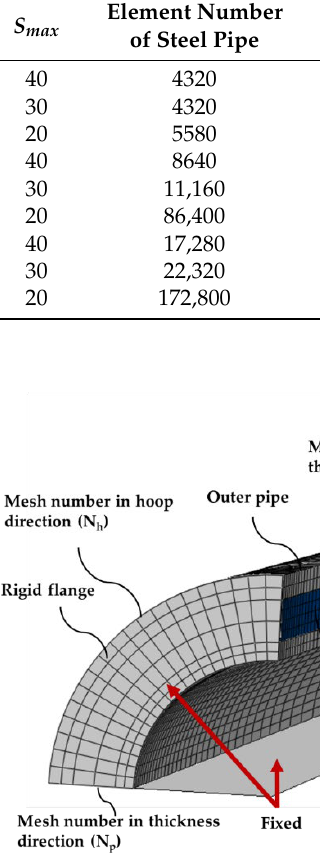
Figure 9. Schematic of the meaning of each item is shown in Table 5.